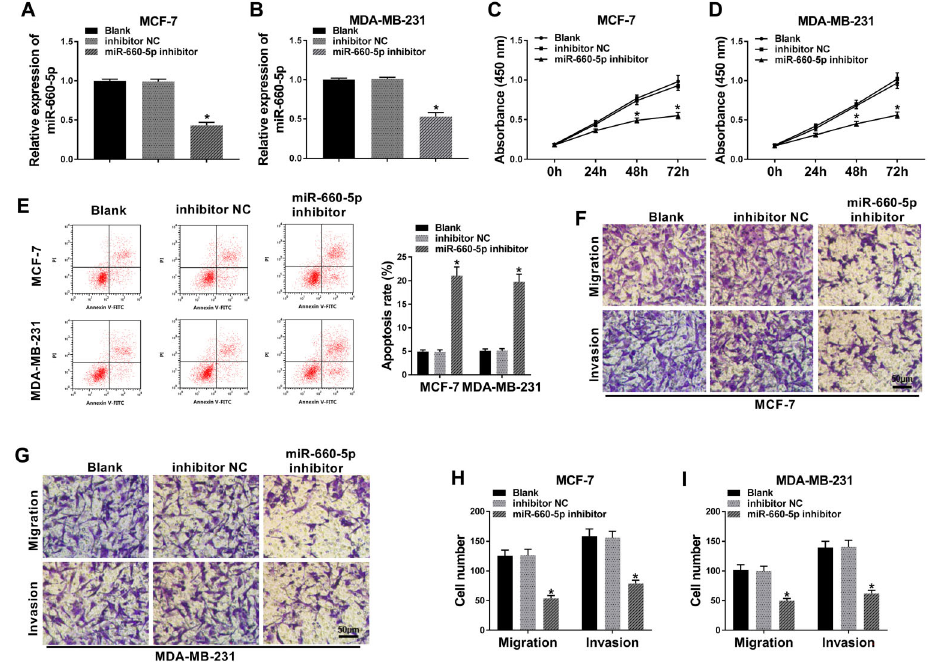
Figure 2. A and B , The knockdown ef fi ciency of miR-660-5p inhibitor was measured in MCF-7 and MDA-MB-231 cells (n=3) by qRT- PCR after transfection for 24 h. C – I , MCF-7 and MDA-MB-231 cells were transfected with inhibitor negative control (NC) or miR-660-5p inhibitor. C and D , Cell proliferation was examined by CCK8 assay. Breast cancer (BC) cells were seeded into 96-well plates (n=6), and cell proliferation curve was generated through measuring the absorbance at 0, 24, 48, or 72 h after transfection. E , BC cells were seeded into 6-well plates (n=3), and fl ow cytometry was performed to assess apoptosis after transfection for 72 h. F – I , Cell migration and invasion were measured in BC cells (n=3) by transwell migration and invasion assays after transfection for 24 h. Data are reported as means ± SD. *P o 0.05